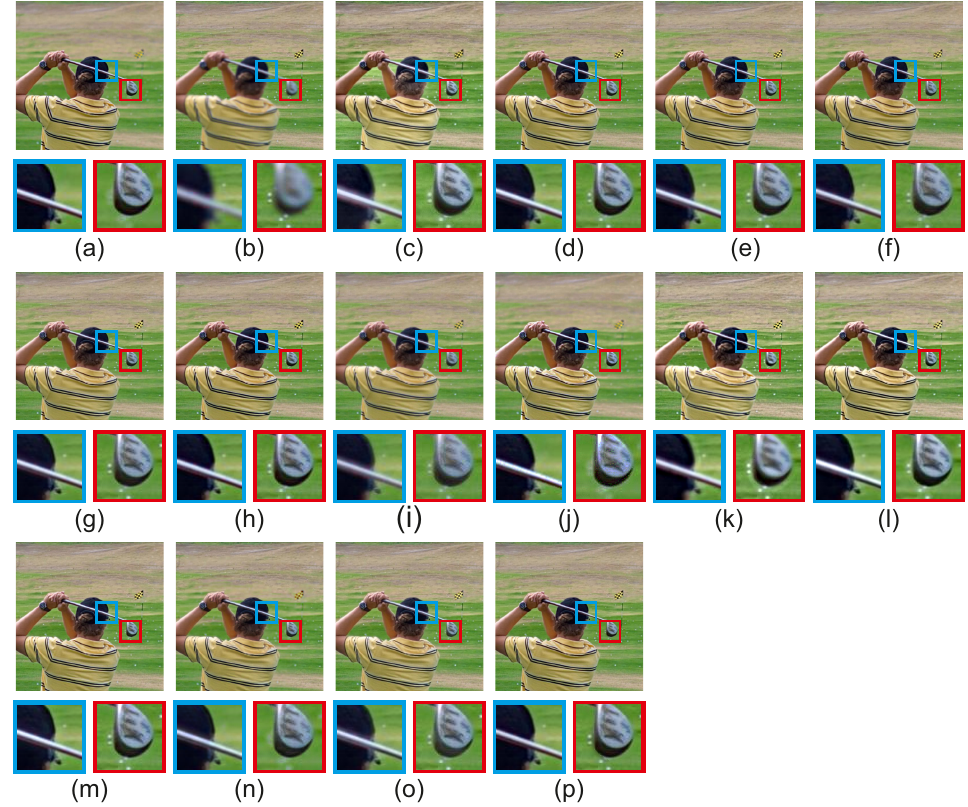
Figure 13. Fused results for the scene ‘Golfer’ of the Lytro dataset [35]. ( a ) Source 1, ( b ) Source 2, ( c ) GBM [36], ( d ) NSCT [14], ( e ) ICA [11], ( f ) DCHWT [17], ( g ) ASR [12], ( h ) IFCNN